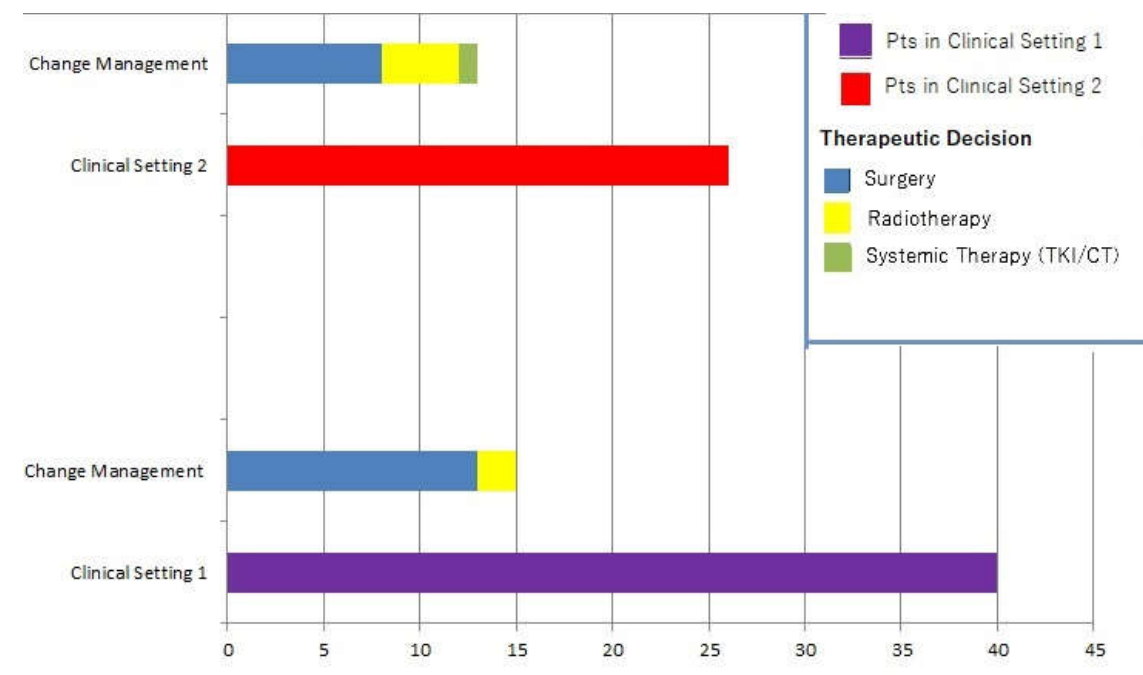
Figure 3. Illustration of PET/CT clinical impact on DTC patients. After PET/CT, subjects were switched to surgery, radiotherapy or systemic therapy.